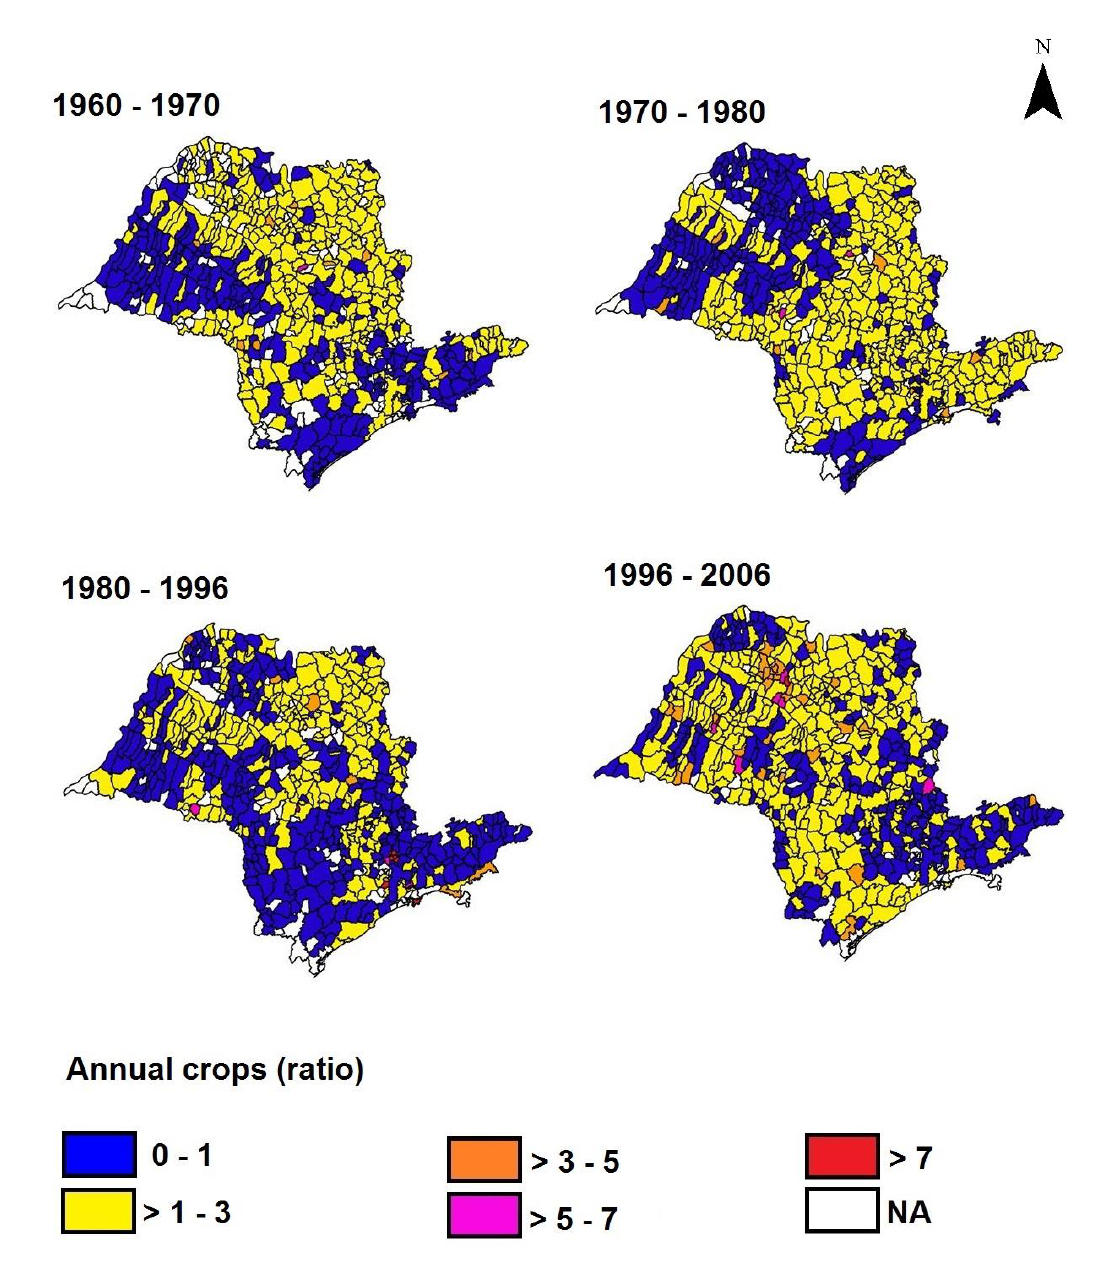
FIGURE A1.7 Annual crop ratio at the municipality-scale for Sao Paulo state calculated for the intervals 1960-1970, 1970-1980, 1980-1996 and 1996-2006. Annual crop ratio was calculated by dividing the annual crop percentage in one census by annual crop percentage in the previous census (e.g. values in 1970 / values in 1960). Ratio values greater than 1 (one) indicate that annual crops increased over the census interval and values lower than 1 (one) indicate that it decreased. Municipality boundaries are shown in black. (NA) Missing